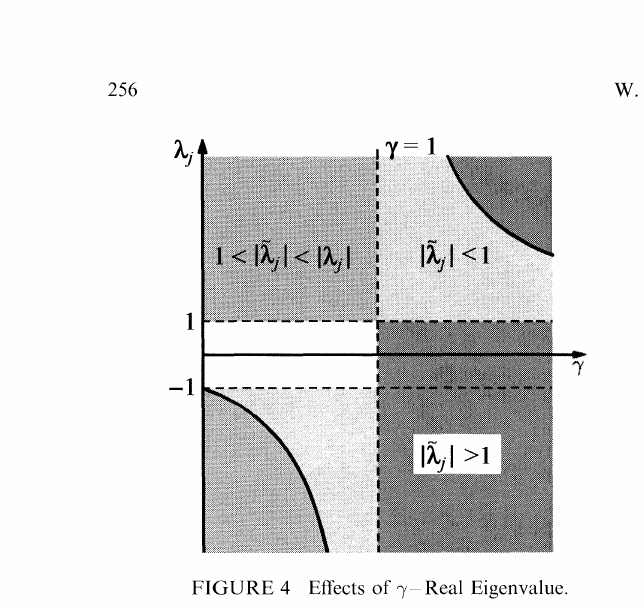
FIGURE 4 Effects of T-Real